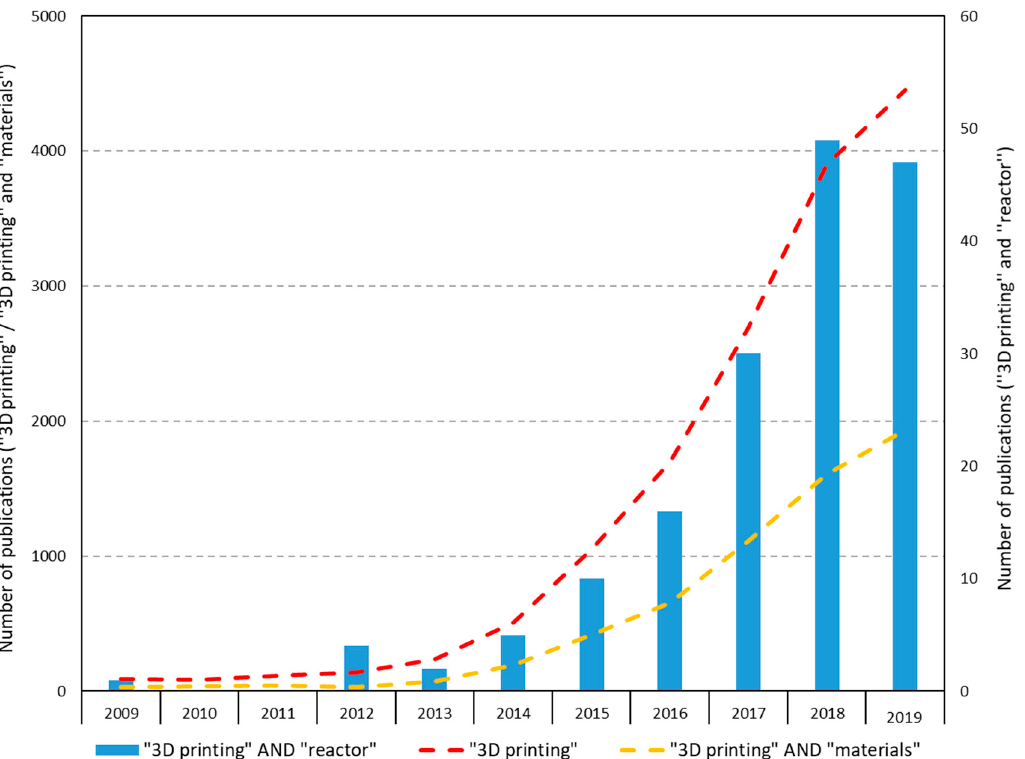
Figure 5. Science citation index publications on 3D printing from the web of science.